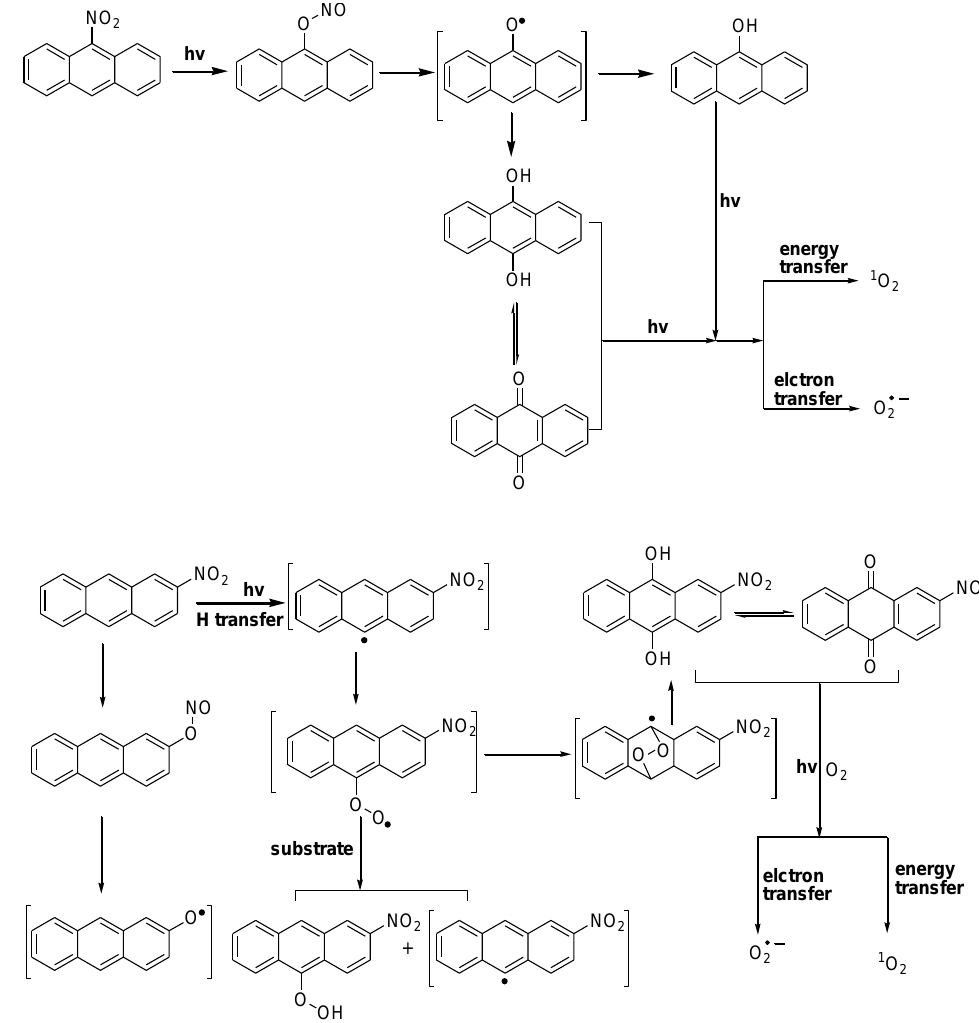
Figure 9. Using 2- and 9-nitroanthracenes as examples to show the proposed mechanism of inducing singlet oxygen, superoxide anion radicals, and carbon-centered free radicals by UVA irradiation of